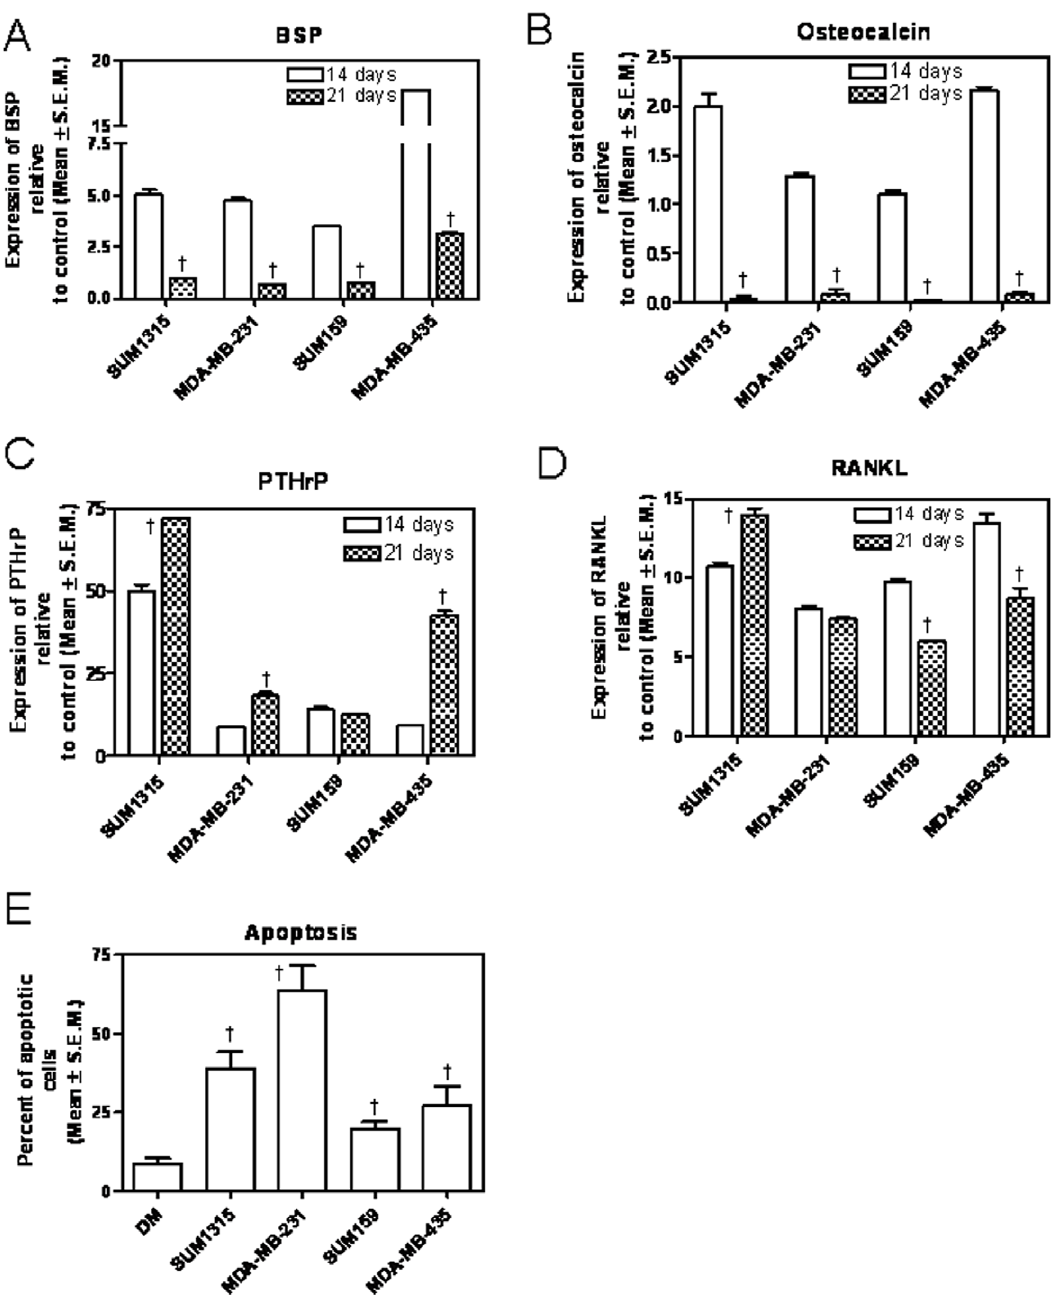
Figure 6. Extended differentiation in presence of tumor cell-conditioned media preserves RANKL and PTHrP expression but promotes osteoblast apoptosis. MC3T3 cells were grown in differentiation supplemented with conditioned media from cancer cells for either 14 days or 21days. At the end of each time point RNA was harvested from the differentiated osteoblastic cells and levels of BSP, osteocalcin, PTHrP and RANKL were assessed by qRT-PCR. ( A ) There is a significant decrease in the levels of BSP at 21 days relative to 14 days of differentiation for all four tumor cell lines assessed ( { p , 0.0001 for all tumor cells). ( B )The levels of osteocalcin significantly decrease at 21 days relative to 14 days of differentiation ( { p , 0.0001 for all tumor cells). ( C ) The levels of PTHrP remained at elevated levels at 21 days post-initiation of differentiation (SUM1315: { p=0.0005; MDA-MB-231: { p=0.0006; SUM159: p . 0.05; MDA-MB-435: { p , 0.0001). ( D ) The levels of RANKL also remained elevated 21 days after differentiation. (SUM1315: { p=0.0023; MDA-MB-231: p=0.07; SUM159: { p=0.0002; MDA-MB-435: { p=0.004). The levels of RANKL and PTHrP were assessed by qRT-PCR. ( E ) Assessment of apoptosis was done at the end of 21 days post initiation of differentiation. Fluorescein conjugated TUNEL staining was performed to assay for apoptosis followed by nuclear staining with DAPI and cytoskeleton staining with phalloidin. Percentage of apoptotic cells was calculated as the number of cells with green fluorescence in the nucleus divided by the total number of cells (represented by the blue DAPI stain) in each field of view. Enhanced apoptosis of osteoblasts was noted in presence of conditioned media from all tumor cells (SUM1315 ( { p=0.005), MDA-MB-231 ( { p=0.002), SUM159 ( { p=0.01), MDA-MB-435 ( { p=0.04)).